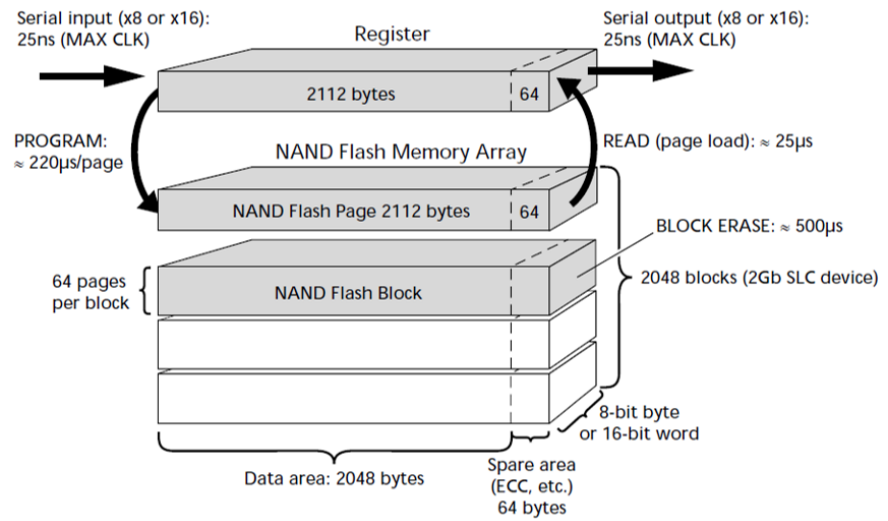
Figure 1. The organizational structure of a NAND flash device. [Source: Micron Technology